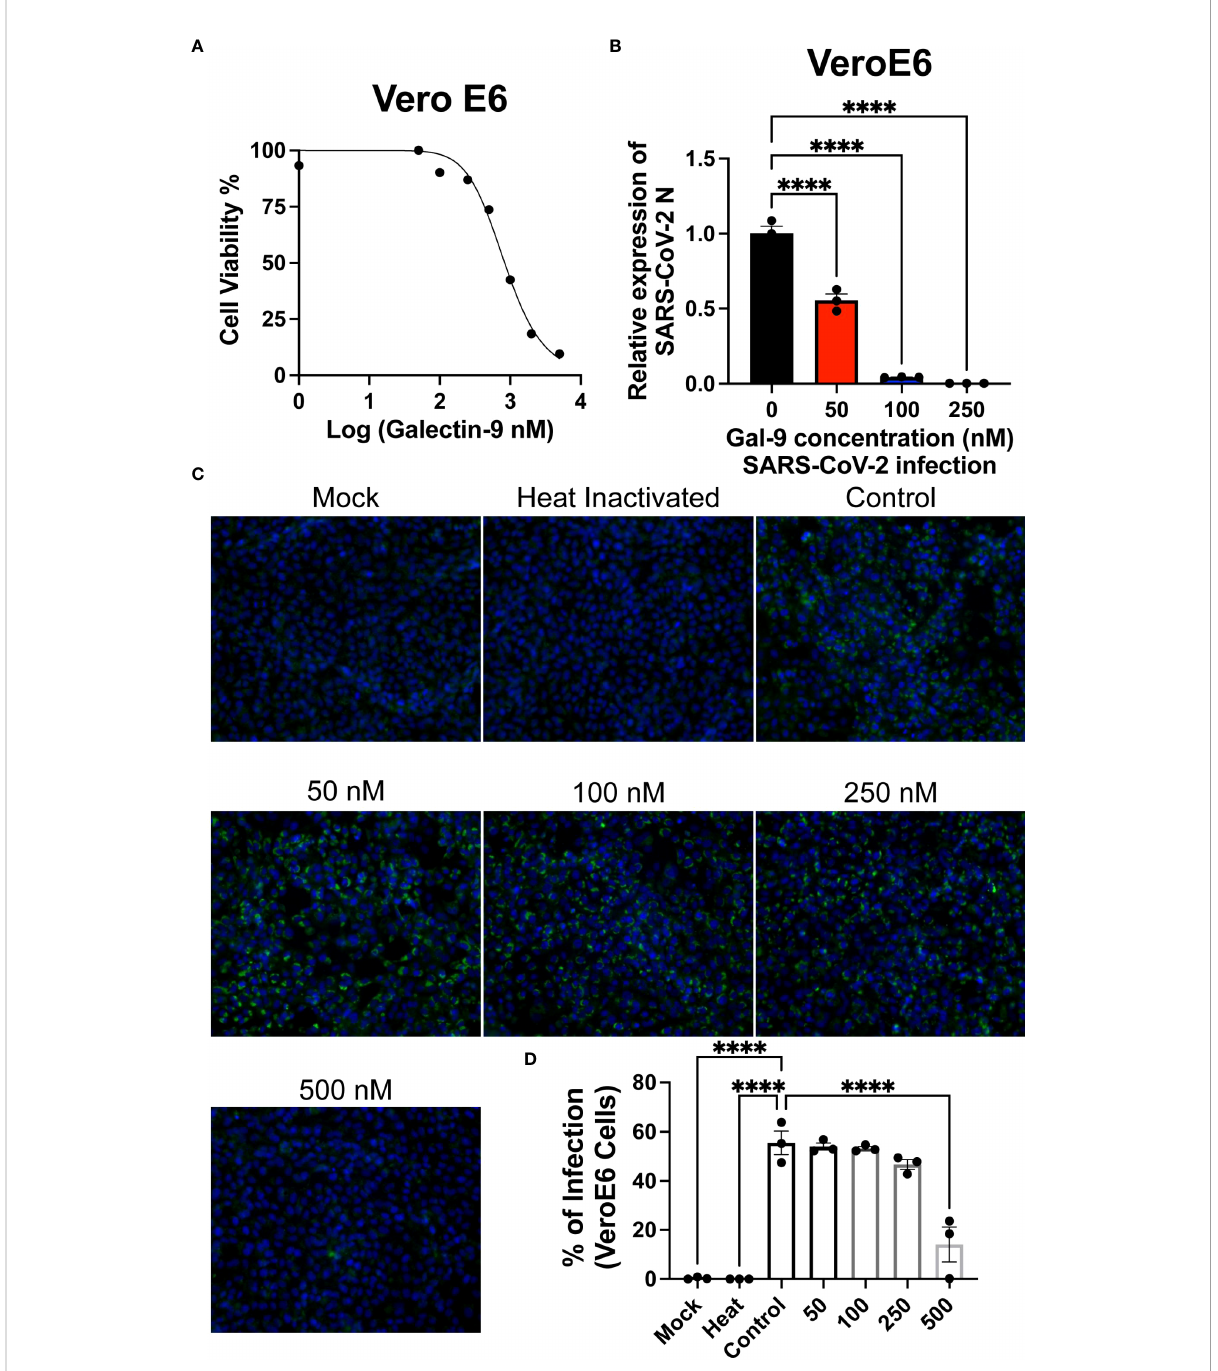
FIGURE 2 Recombinant human Gal-9 (rh-gal-9) decreases SARS-CoV-2 production in Vero E6 cells. (A) Vero E6 cells were treated with different doses of Gal-9 for 48 h followed by measurement of the cytotoxicity of Gal-9 was determined by MTT assay. (B) Vero E6 cells were pretreated with Gal-9 at the indicated concentrations for six hours, followed by infection with SARS-CoV-2 (at the MOI of 0.01) for 24 h in the presence of Gal-9. 24 hpi, cells were harvested for RT-qPCR detecting the N expression. (C) Vero E6 cells were treated with Gal-9 and infected with SARS-CoV-2 as described in (B) , cells then were fi xed and analyzed by immuno fl uorescence assay by staining with DAPI (blue) or anti-N Ab (green). (D) Quanti fi cation of SARS-CoV-2 infected cells in Vero E6 cells (shown in panel C). n=3/group, ****p<0.0001. One- Way ANOVA. Data are represented as mean +/-